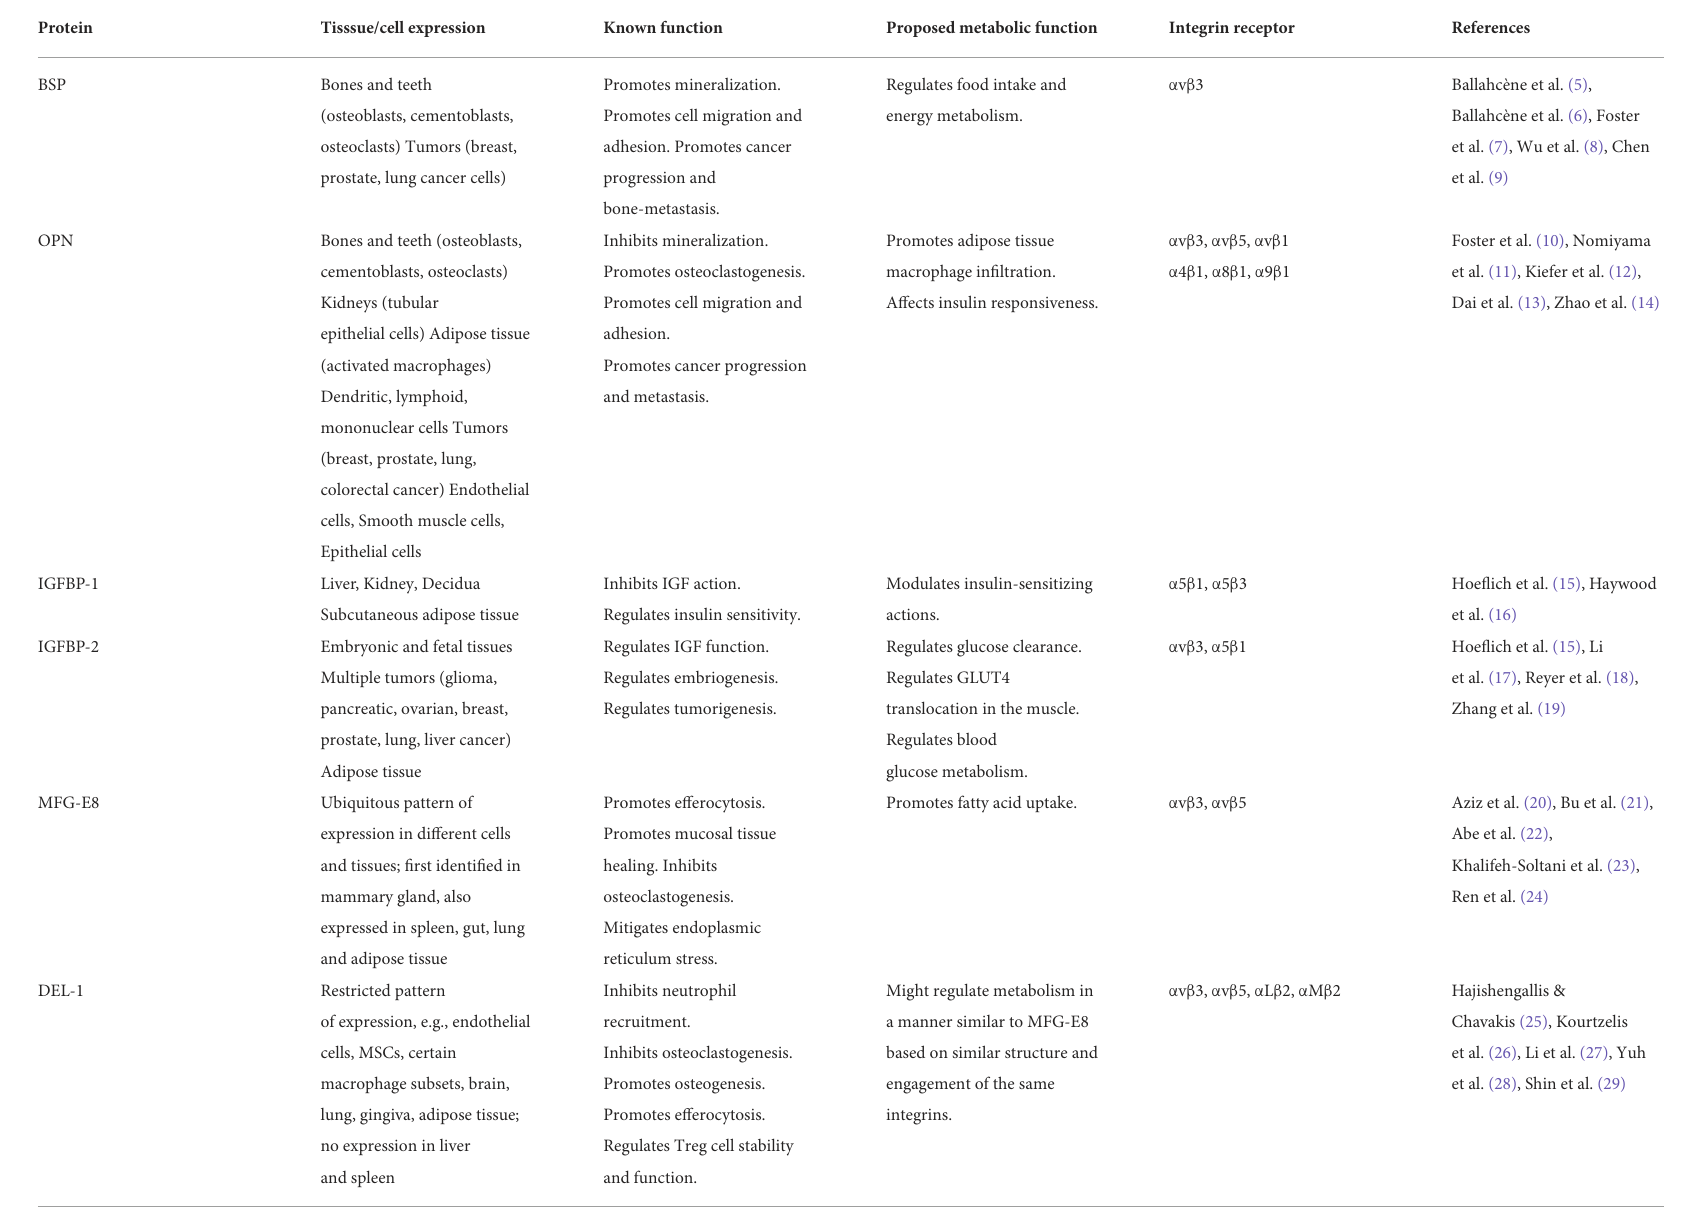
TABLE 1 RGD proteins and metabolic